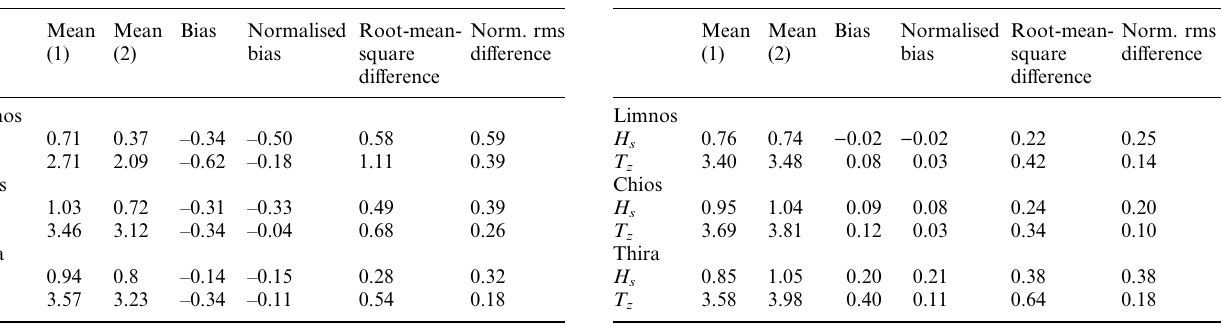
Table 4. Statistics for the storm September 1990, -48 points. Comparison of results from WAM model using UKMO and ECMWF winds